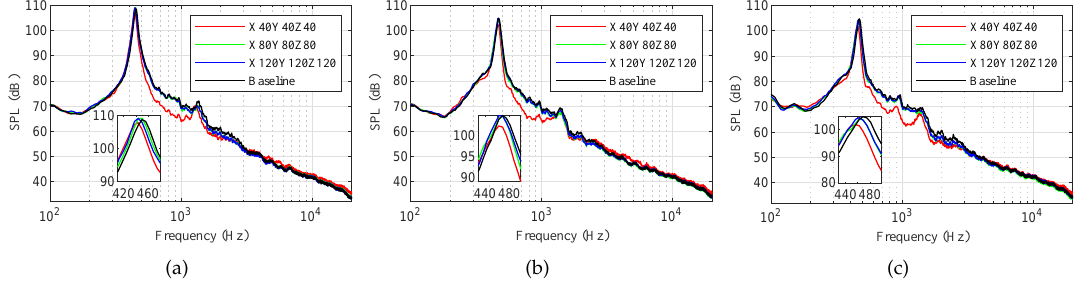
Figure 8. Typical noise spectra between the porous leading edges and the baseline configuration ( V ∞ = 50 m/s): ( a ) L = 100 mm, α = 0 ◦ ; ( b ) L = 200 mm, α = 0 ◦ ; and ( c ) L = 200 mm, α = 10 ◦